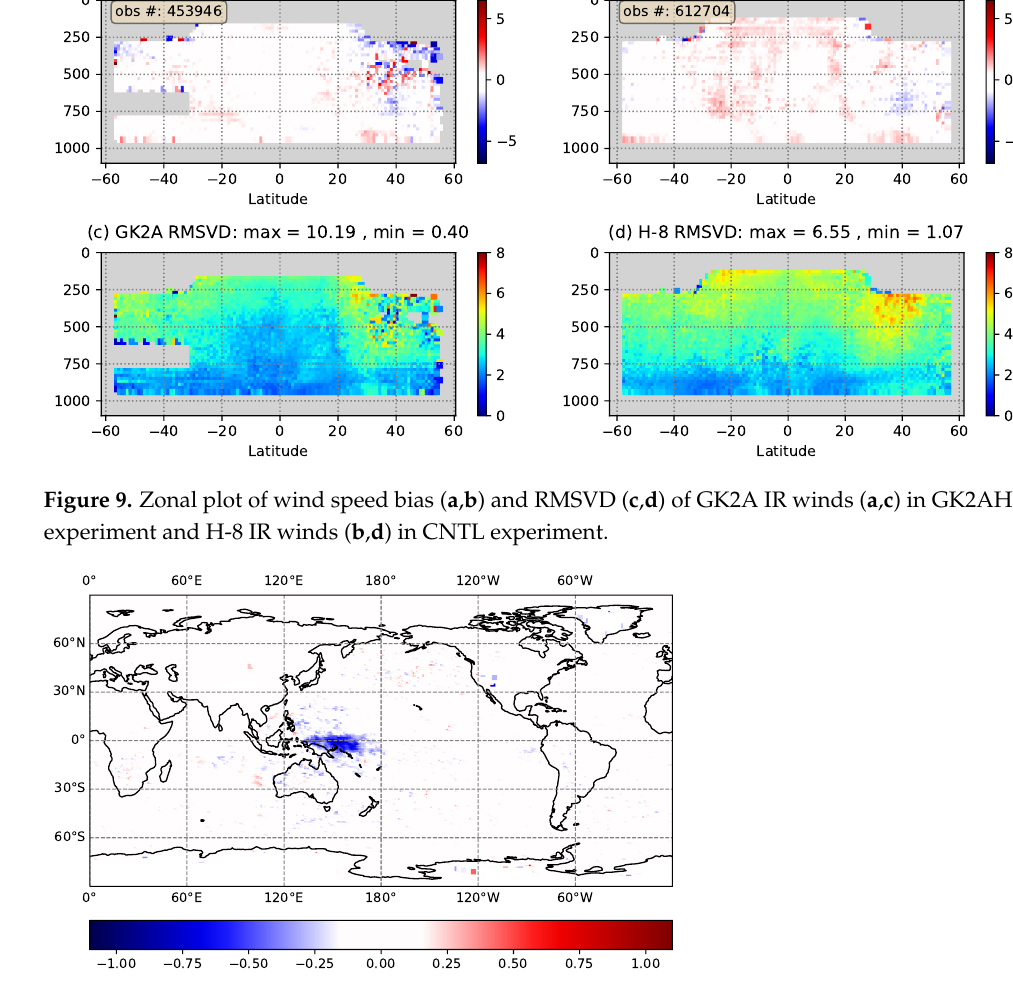
Figure 10. Averaged difference between between CNTL and GK2AHE u-wind analysis errors at 850 hPa from 1 December 2020 to 31 January 2021. It represents closeness of GEOS analysis to ERA5 reanalysis: |GK2AHE-ERA5|-|CNTL-ERA5|. The blue color means a reduction in analysis error by adding GK2A